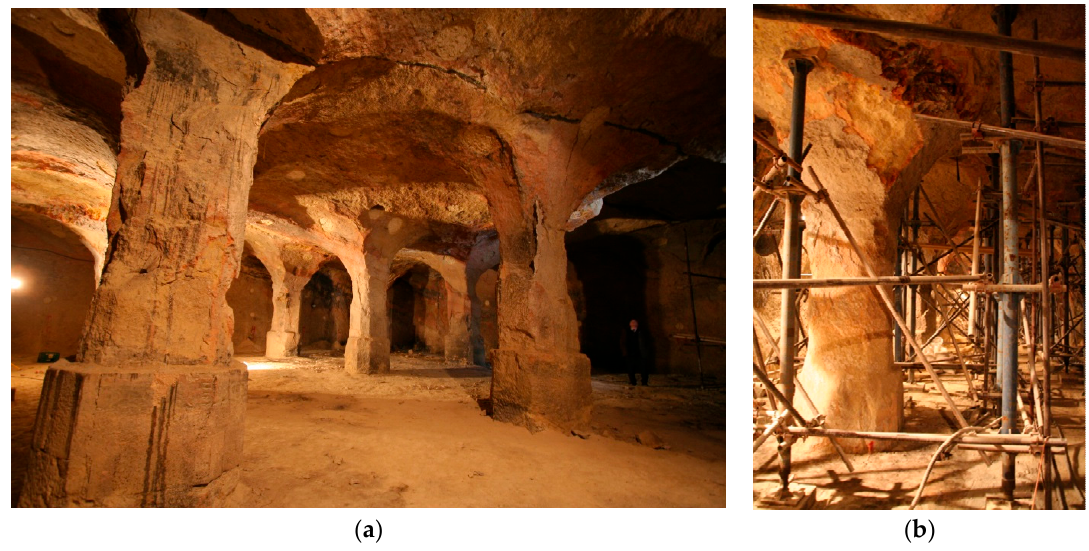
Figure 3. Photographs of the gunpowder depot in Room 2: ( a ) after the completion of remedial works and ( b ) during the period of scaffold support (the failure modes of columns can be seen in both